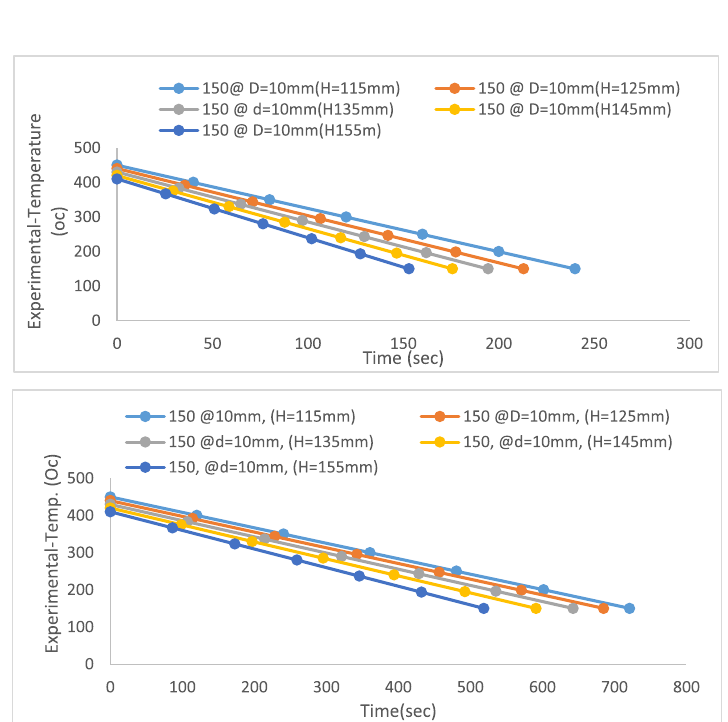
Fig. 6 Temperature time at 150 °C, D